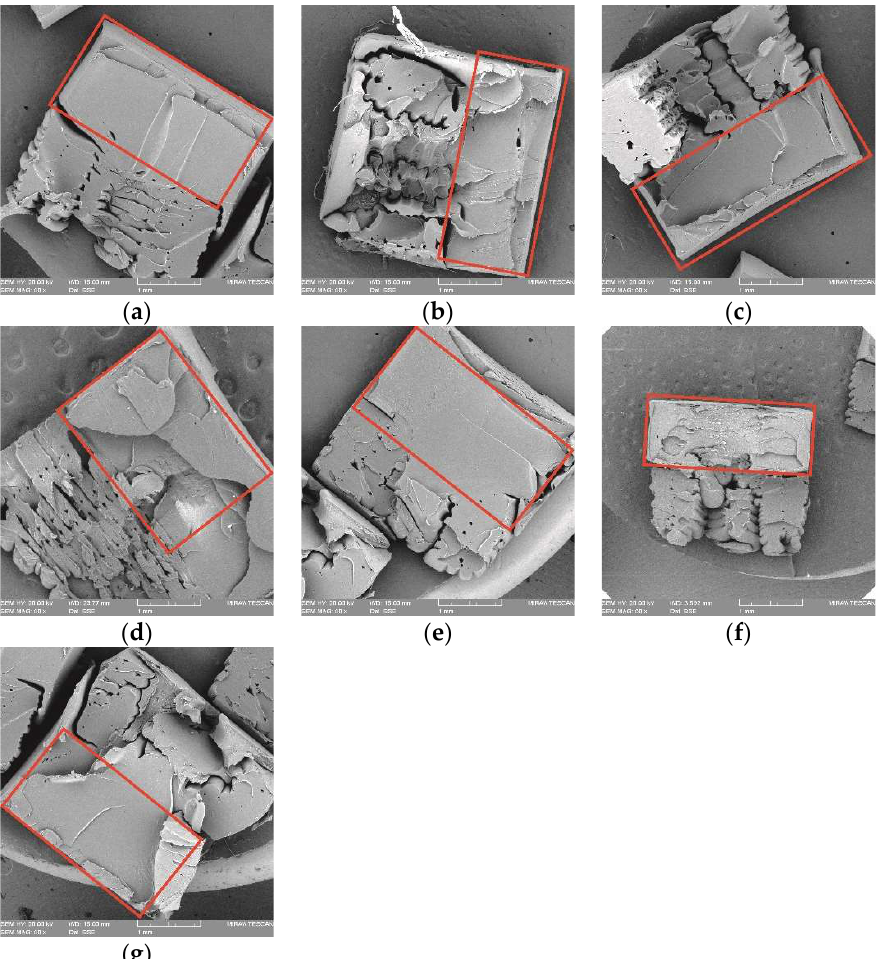
Figure 10. SEM images showing the fracture sections of specimens, in which the IM part is marked with a red square: ( a ) NJ25; ( b ) NJ50; ( c ) NJ75; ( d ) MC50; ( e ) FC50; ( f ) MT50; and ( g ) FT50.